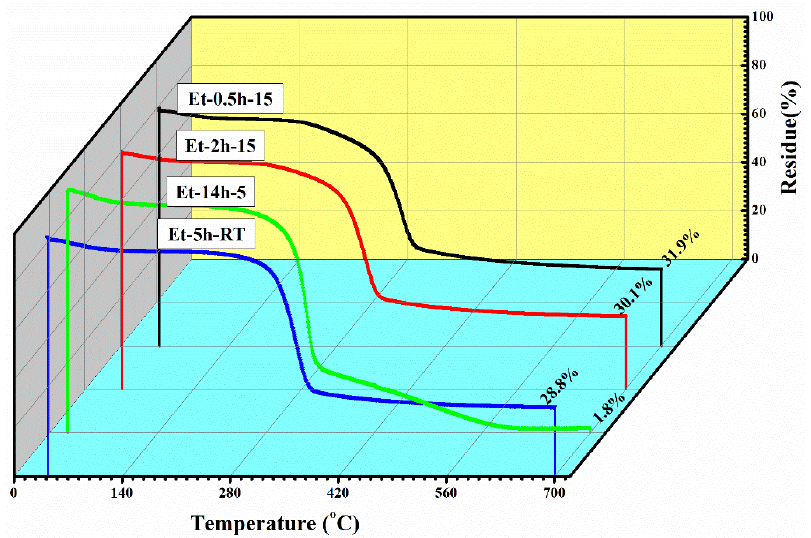
Figure 5. Thermogravimetric analysis curves of the coated fabric obtained under various conditions.